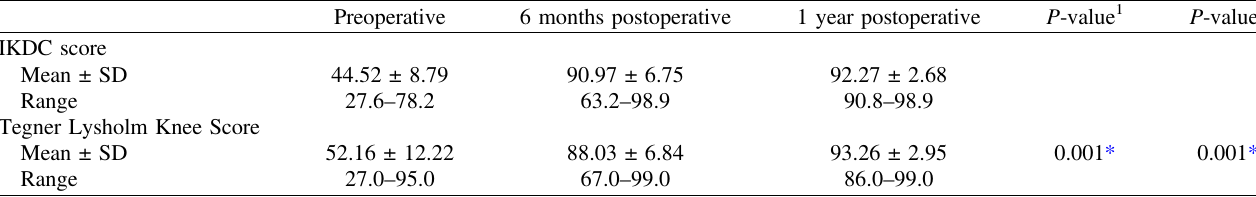
Table 2. IKDC and Tegner Lysholm Knee Score pre- and postoperatively.